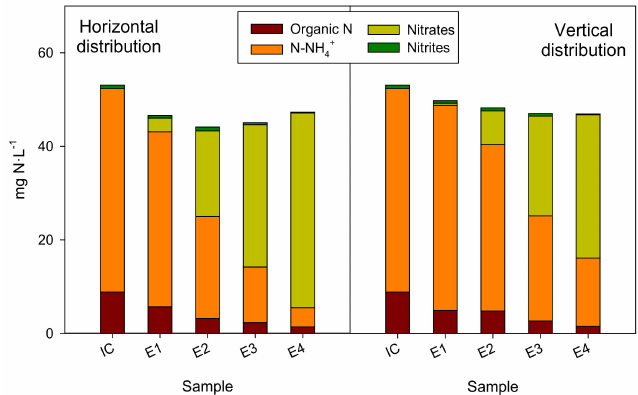
Figure 7. Evolution of the nitrogen species along the treatment in the two pilot